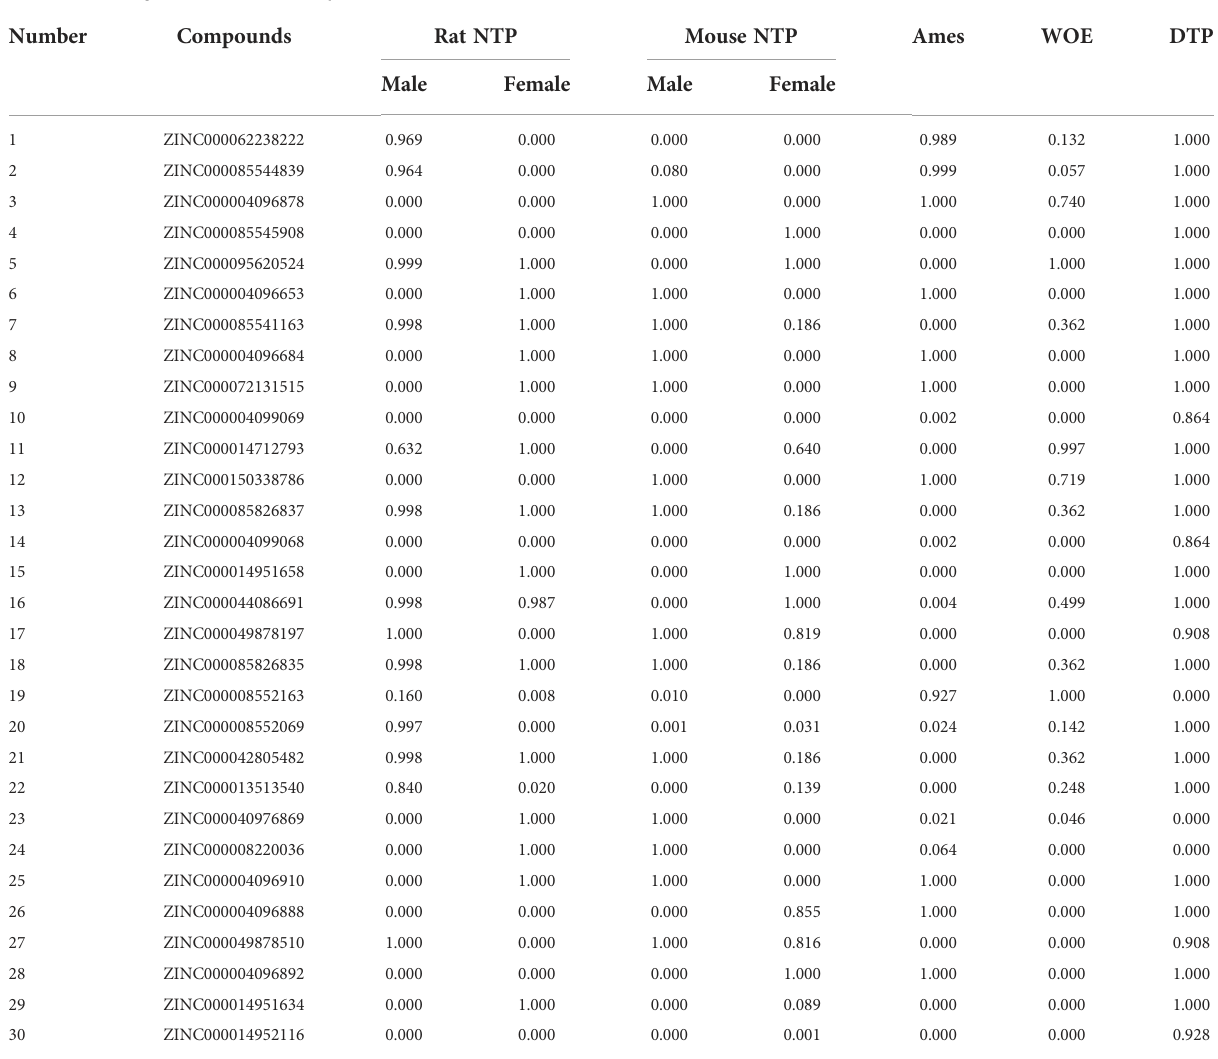
TABLE 2 Toxicity calculation of the top 30 materials.